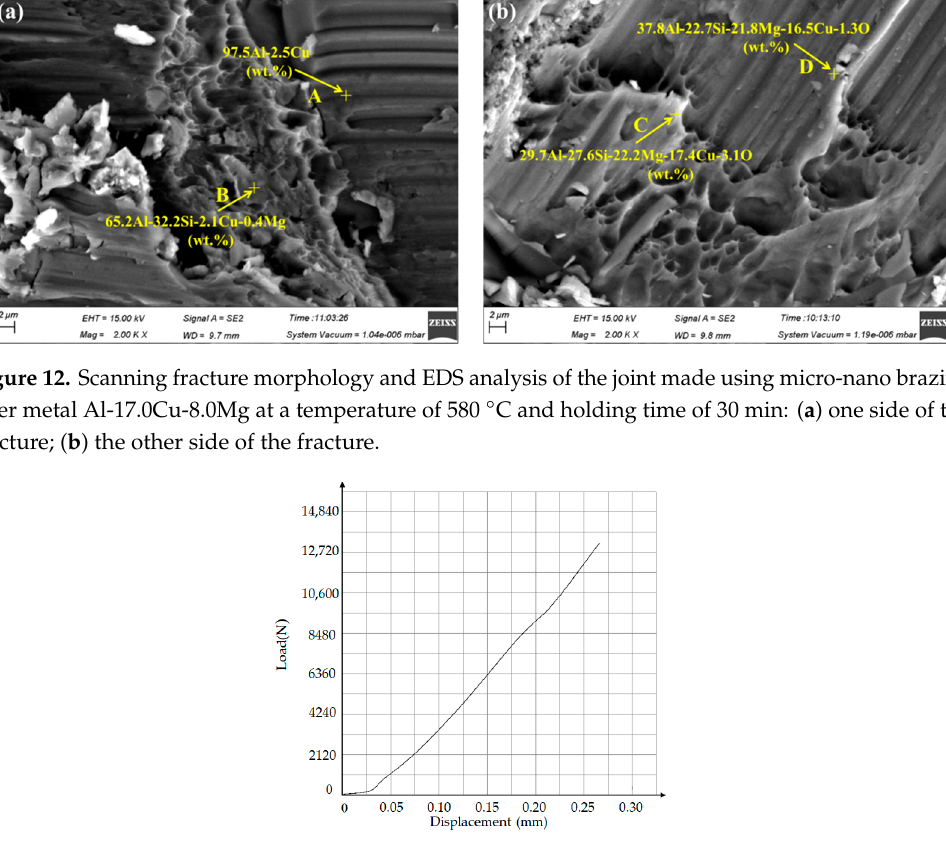
Figure 13. Shear curve at a temperature of 580 °C and holding time of 30 min.